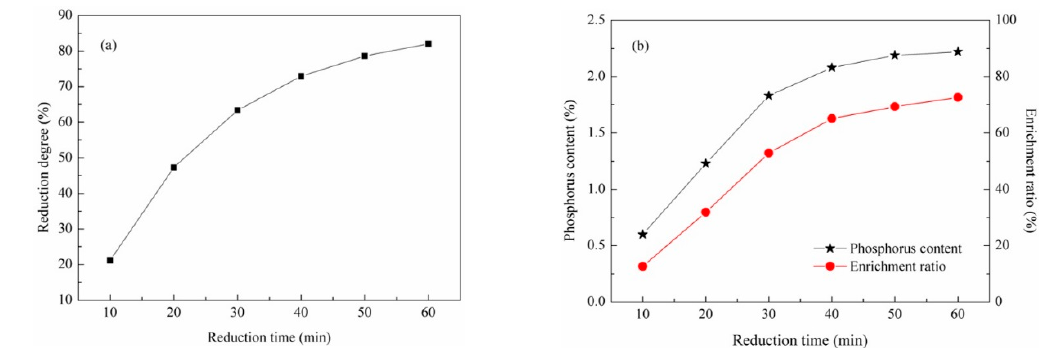
Figure 5. Effect of reduction time on the reaction behavior of phosphorus: ( a ) reduction of apatite to phosphorus; and ( b ) phosphorus enrichment in reduced iron.